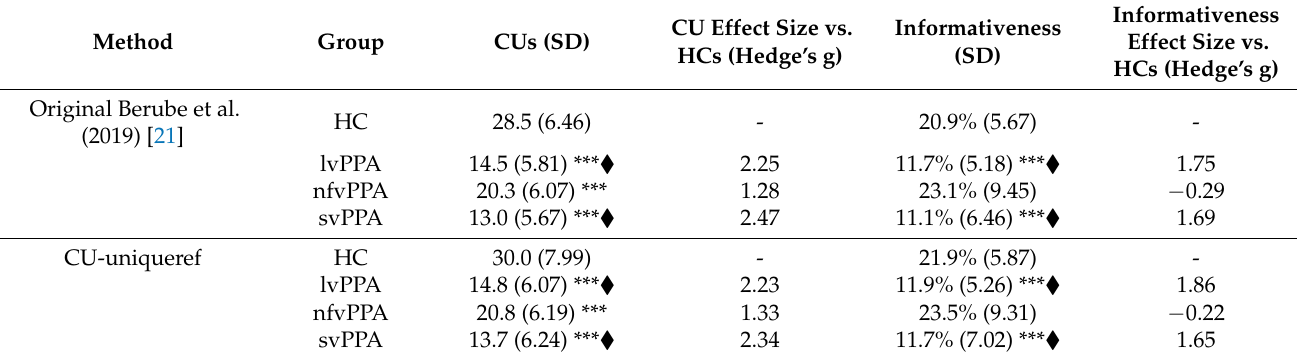
Table 3. The average CU and informativeness scores derived from both the original Berube et al. (2019) [21] and CU- uniqueref methods for all